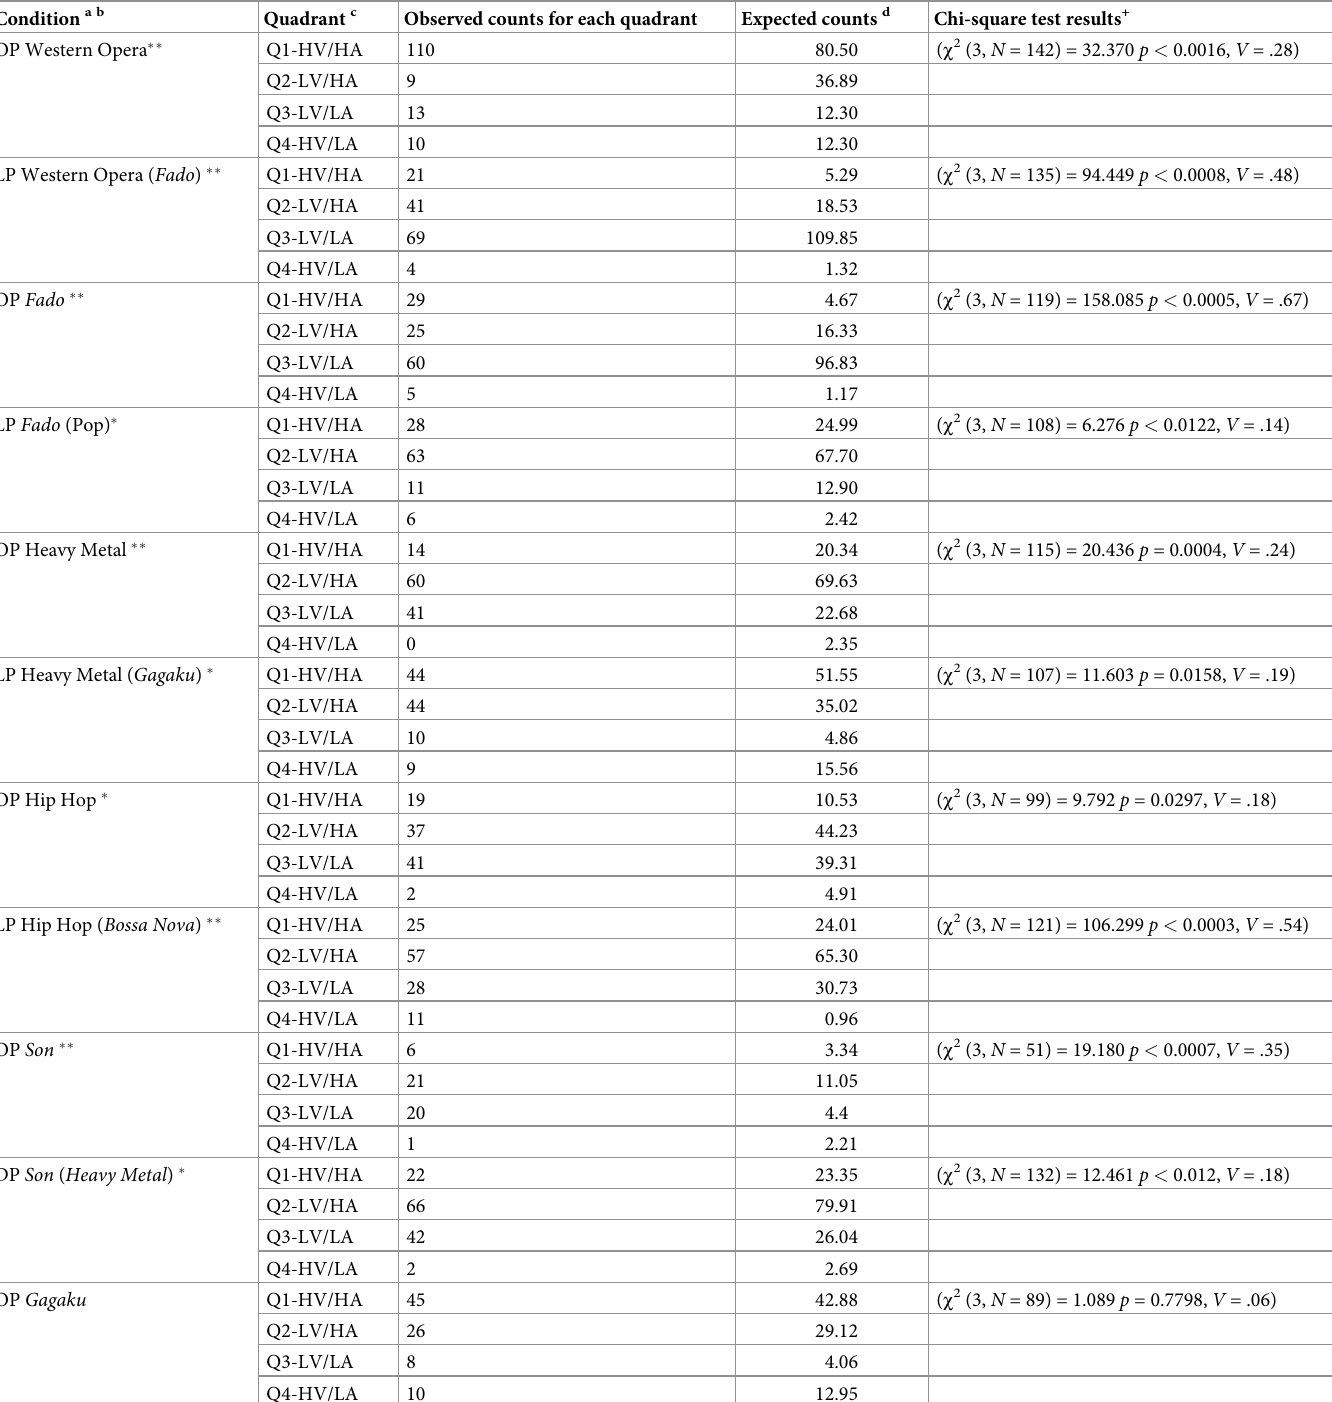
Table 1. Chi square test results for both original priming and lure priming using corresponding unprimed as